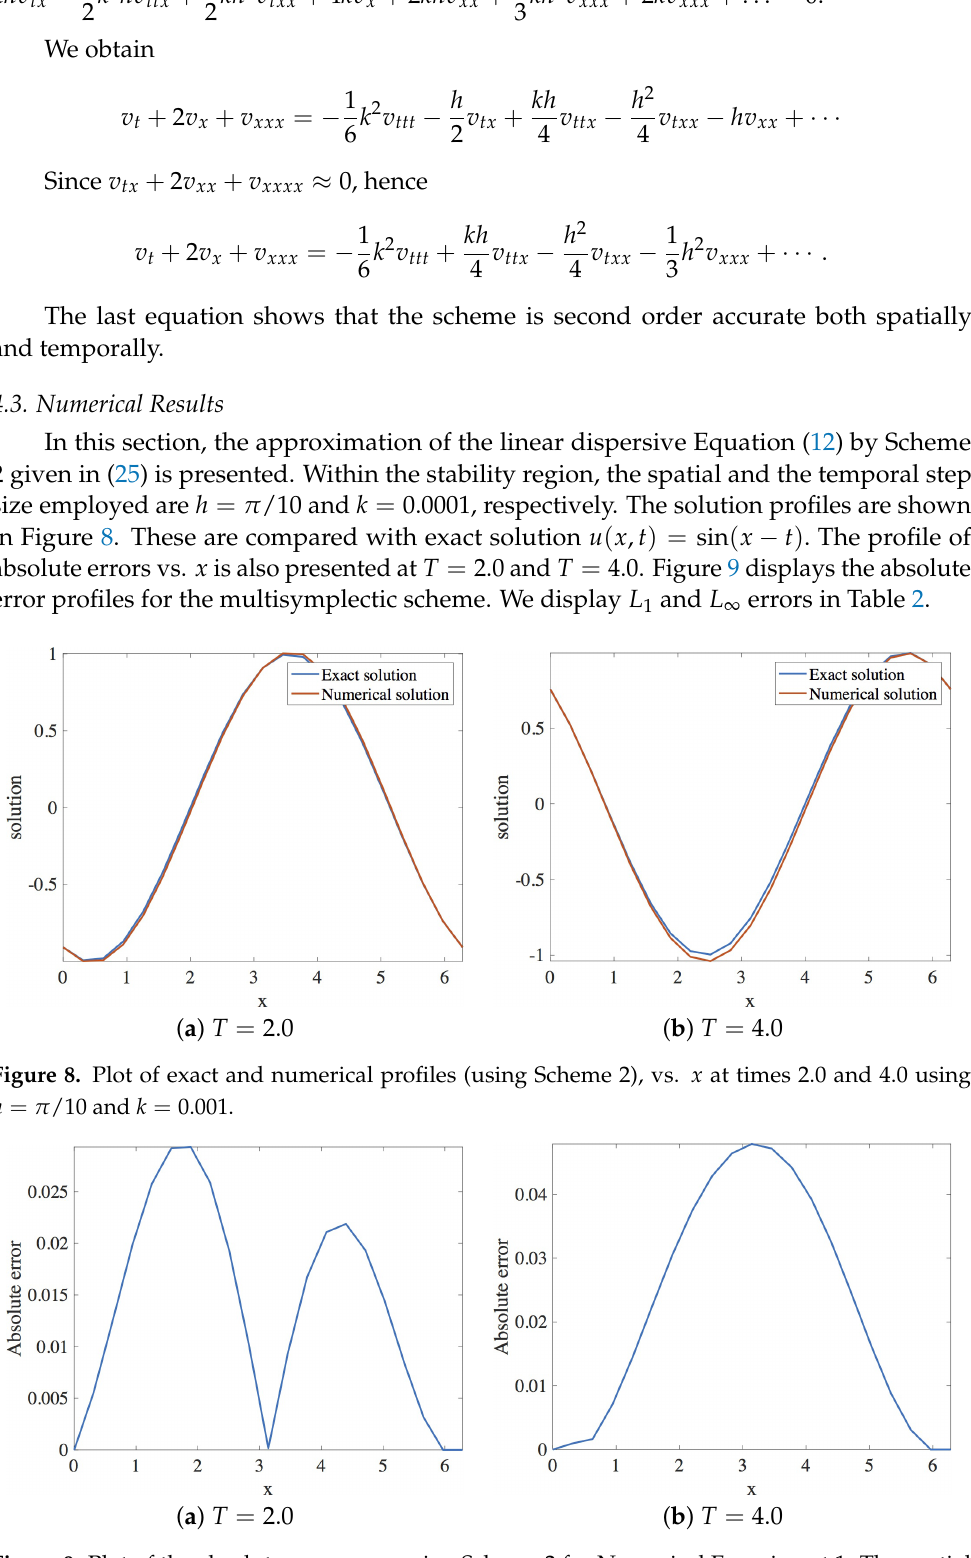
Figure 9. Plot of the absolute error vs. x using Scheme 2 for Numerical Experiment 1. The spatial and temporal step sizes are h = π /10 and k = 0.001,